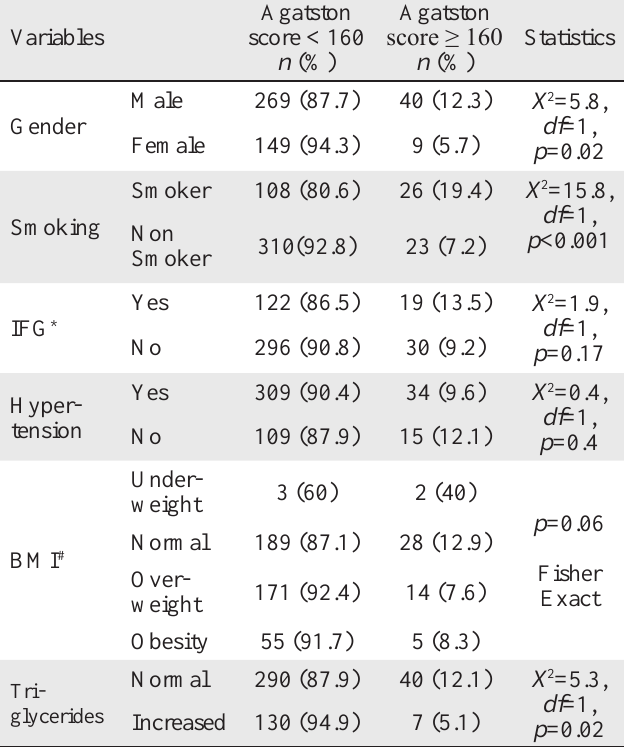
Table 1 : Relationship between Agatston score category and different parameters (N =